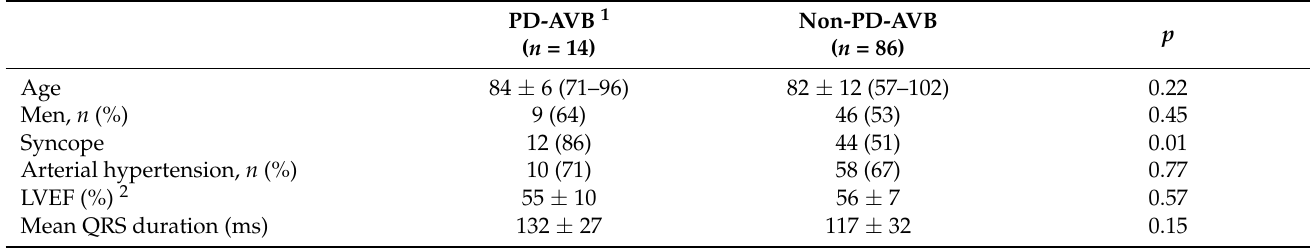
Figure 2. Example of patient presenting with PD-AVB initiated by a premature atrial contraction, recorded on a telemetry strip (upper panel). Another episode could be recorded in the same patient complete AVB (lower panel). Table 1. Characteristics of patients with pause-dependent atrioventricular